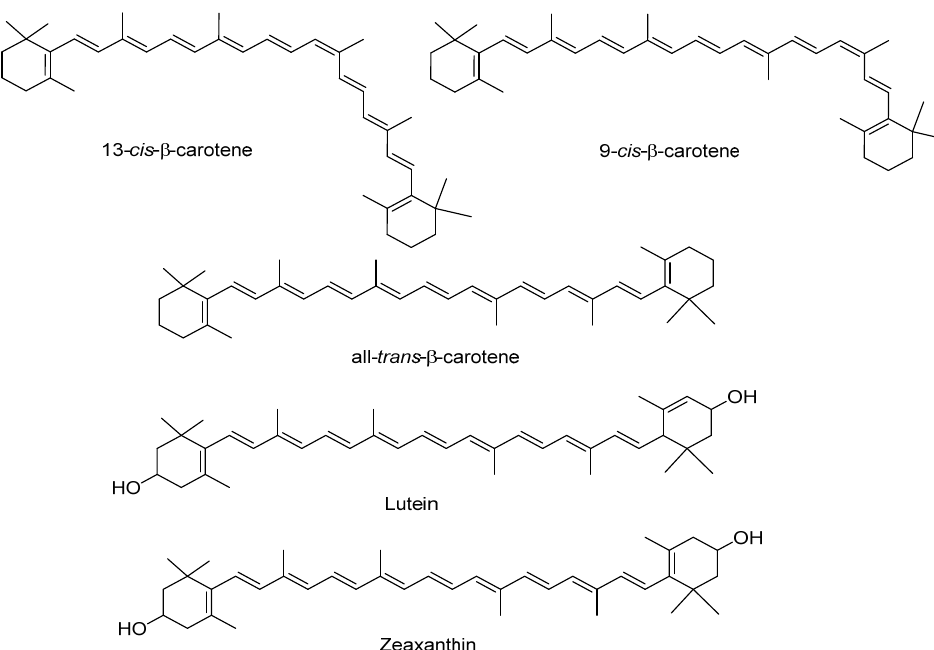
Figure 4. Main carotenoids identified in sweet potato.